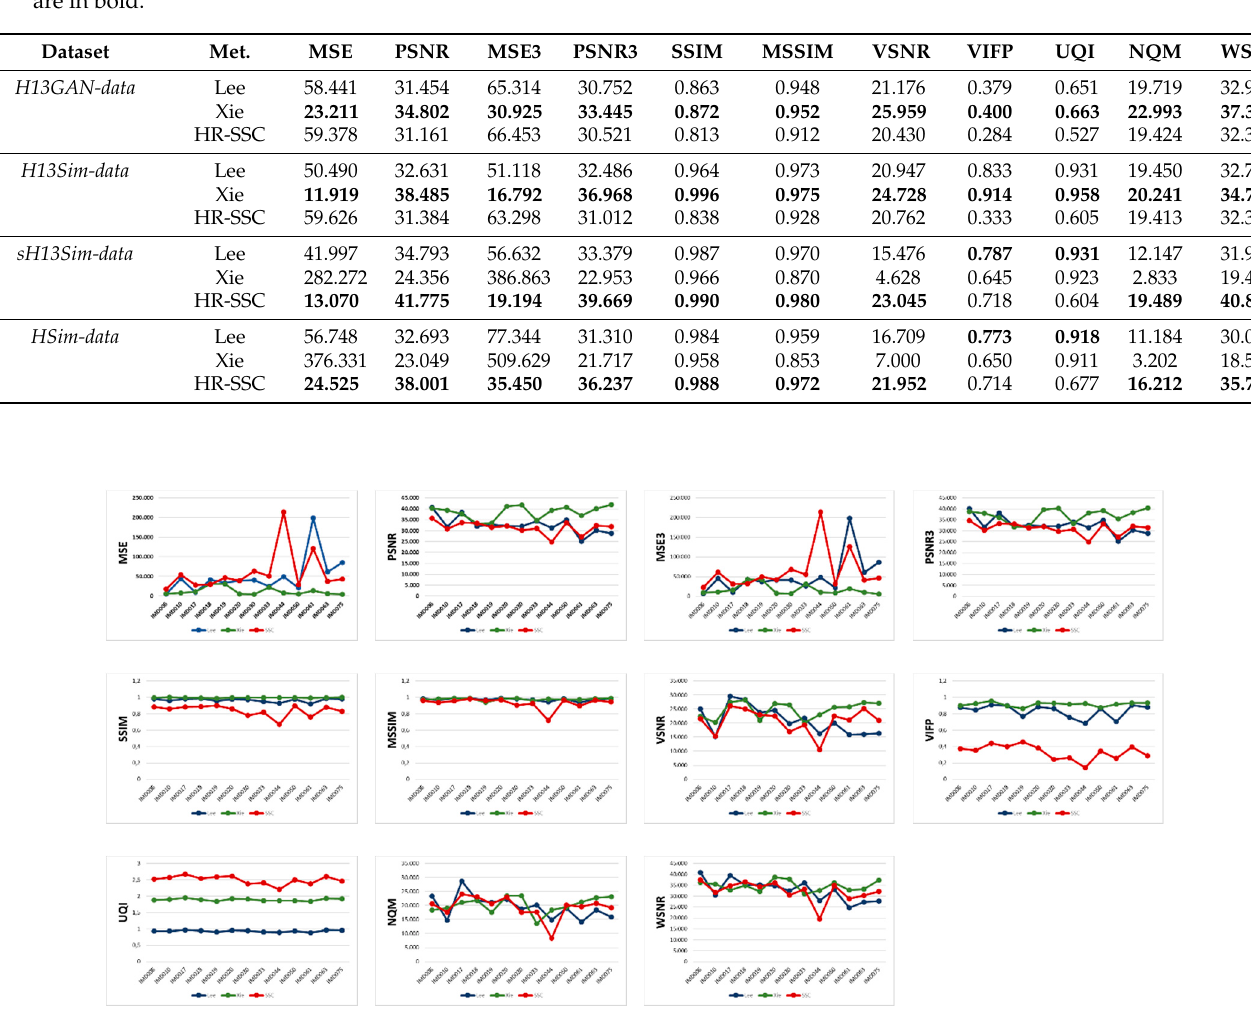
Table 4. Average quality evaluation of the results on H13GAN-data , H13Sim-data , sH13Sim-data , and HSim-data —best results are in bold.